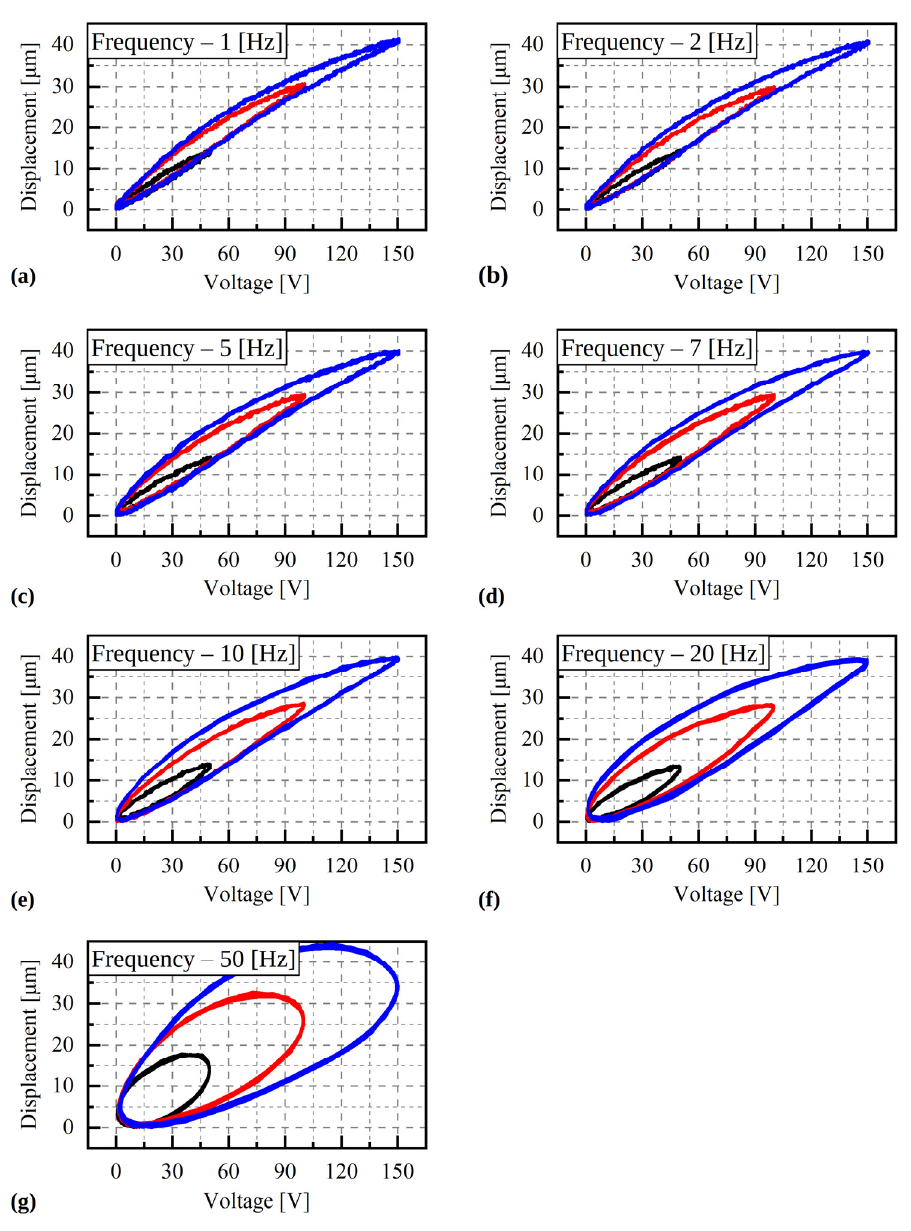
Figure 6. Results of the dynamic test for different excitation frequencies. ( a )—1 Hz, ( b )—2 Hz, ( c )—5 Hz, ( d )—7 Hz, ( e )—10 Hz, ( f )—20 Hz, ( g )—50